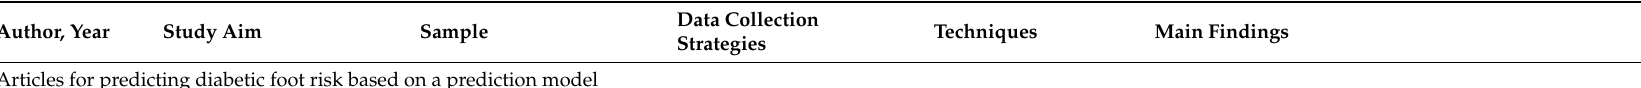
Table 2. Basic characteristics of the included